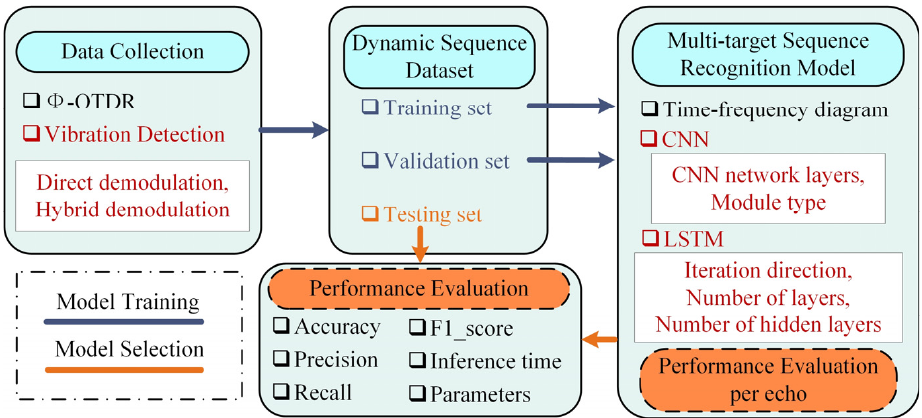
Figure 9. Experimental procedure of the CLSTM-based fiber optic sensing vibration identification method (red sections indicate variables).